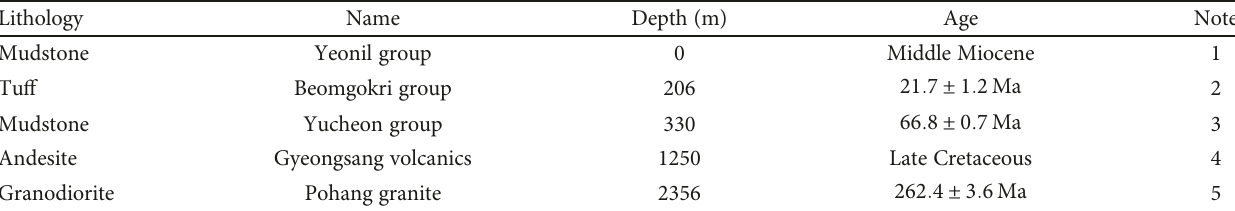
Table 1: Pohang borehole stratigraphy.